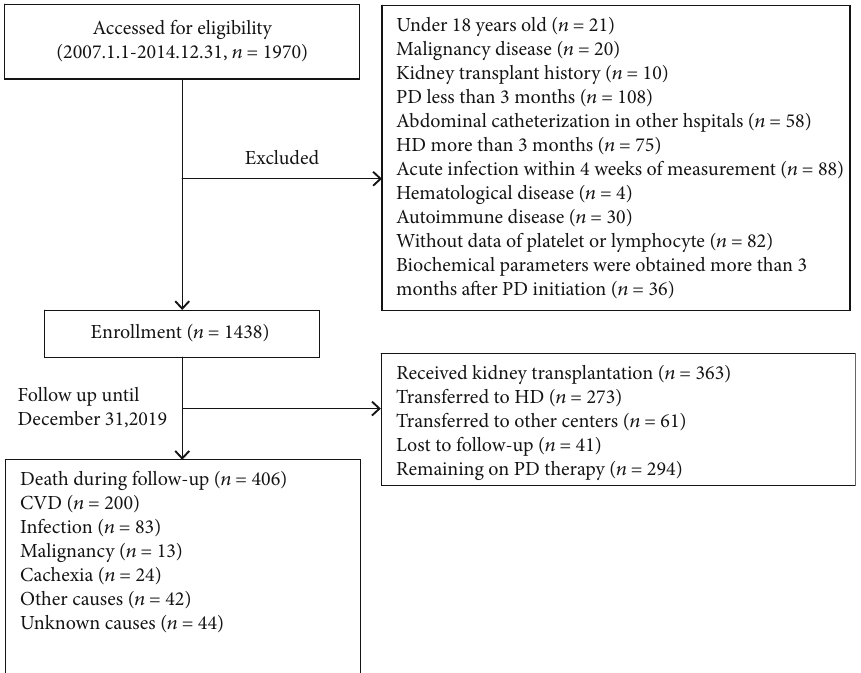
Figure 1: Study fl ow chart. Abbreviation: CVD: cardiovascular disease; PD: peritoneal dialysis; HD: